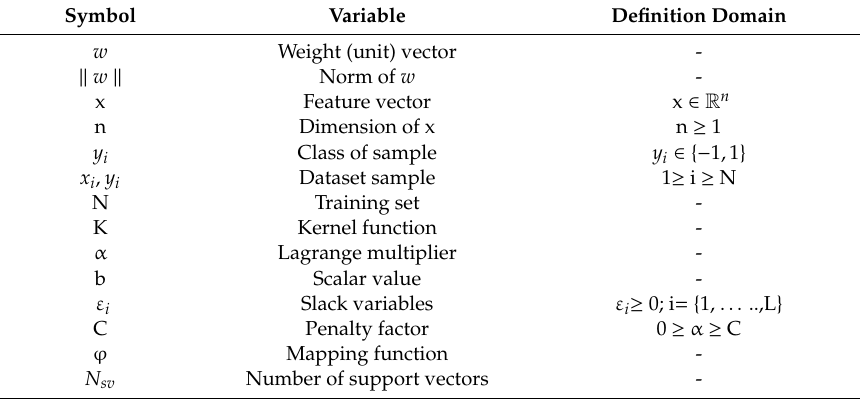
Table A1. Variables used in the SVM classification process.